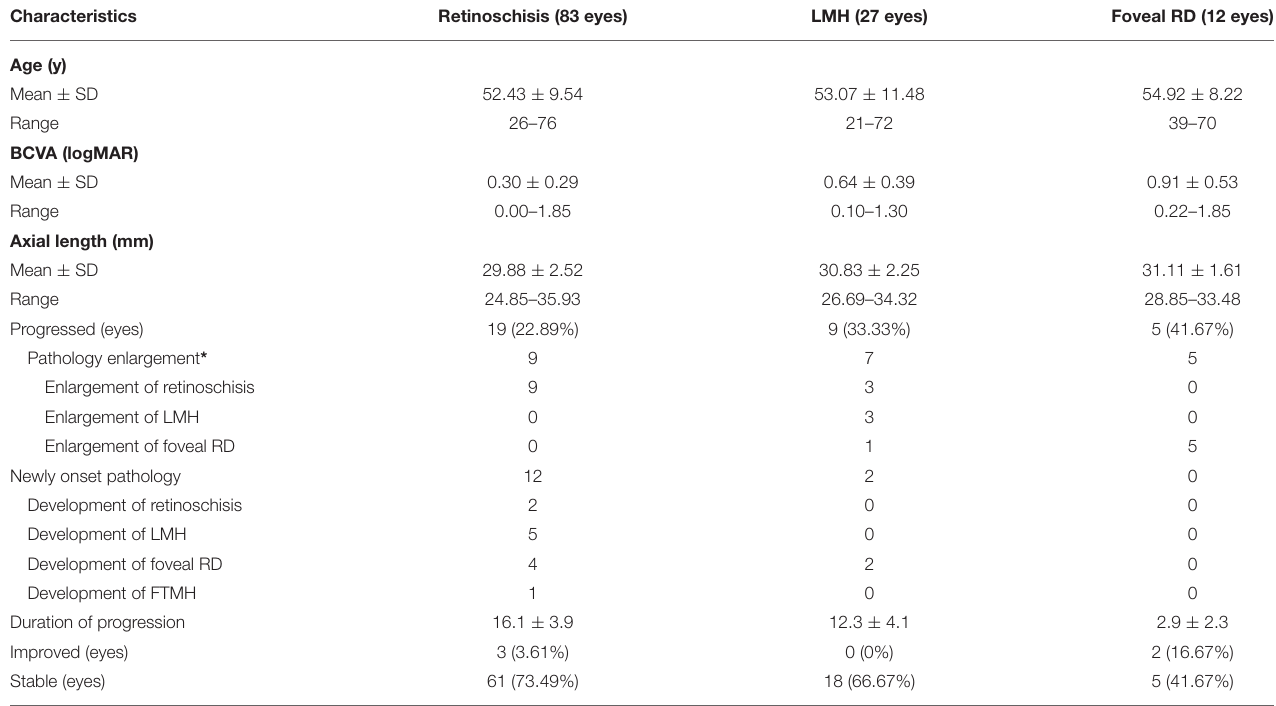
TABLE 2 | Baseline characteristics of patients with different foveal complications. Characteristics